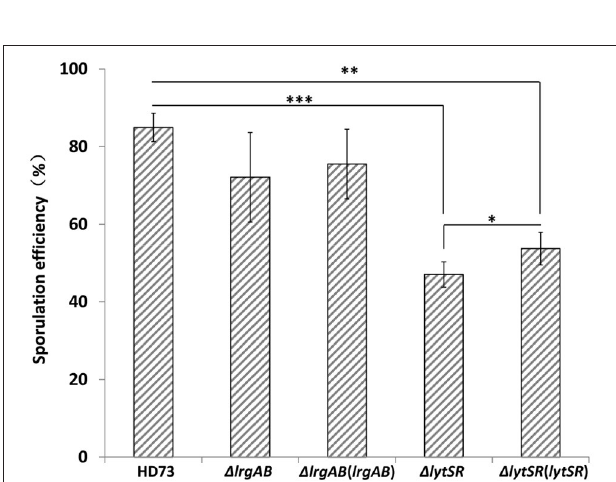
FIGURE 3 | Analysis of sporulation efficiency. Sporulation efficiencies of wild-type HD73, 1 lytSR , 1 lrgAB , 1 lrgAB ( lrgAB ), and 1 lytSR ( lytSR ) were compared. Sporulation efficiency was defined as the ratio of the number of spores to the number of viable cells, multiplied by 100. Values represent the means of at least three independent replicates. The data were analyzed with SPSS (version 19.0) using a t -test. Error bars represent standard